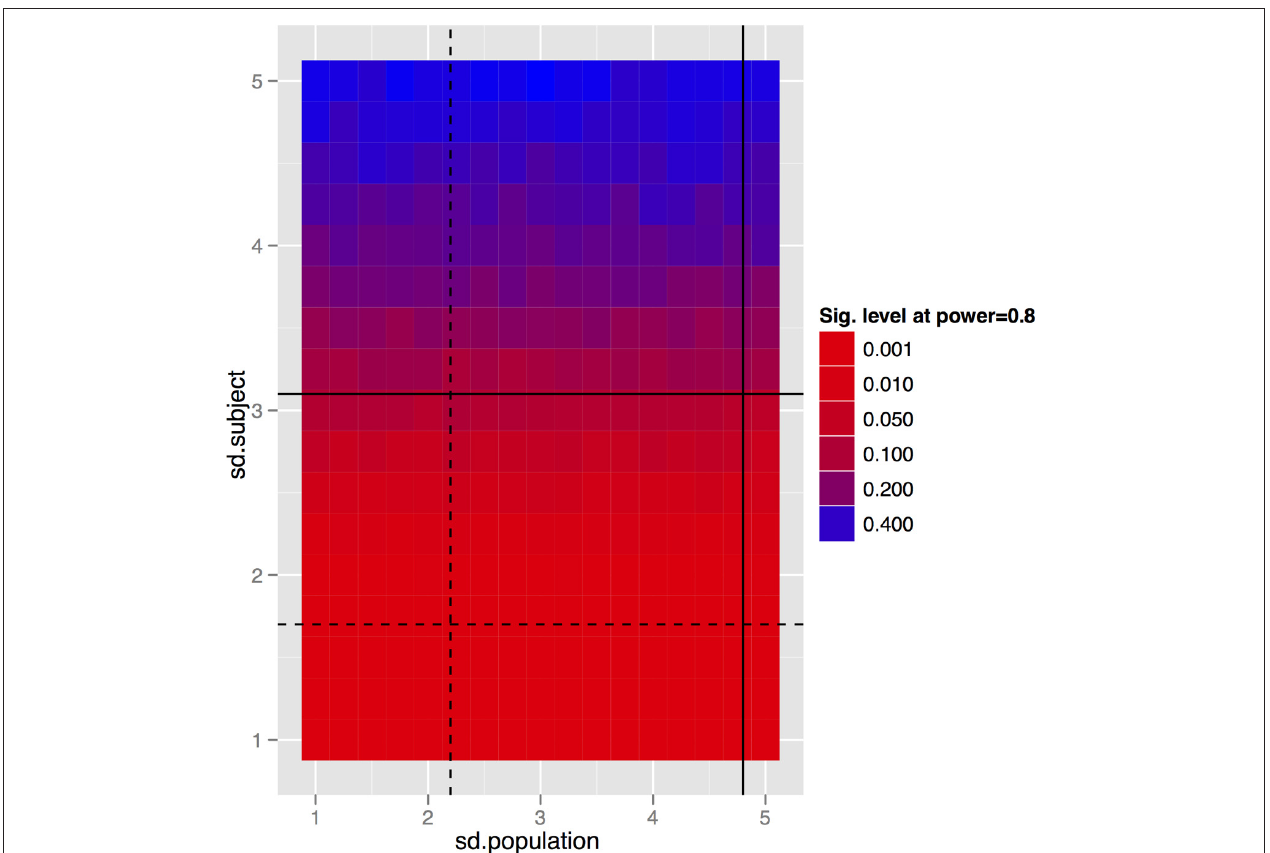
within-subject variance. This simulation again assumes 10 subjects per group and four scans per subject. The black lines indicate standard deviations of absolute (solid) and relative (dashed) volumes as determined by our imaging